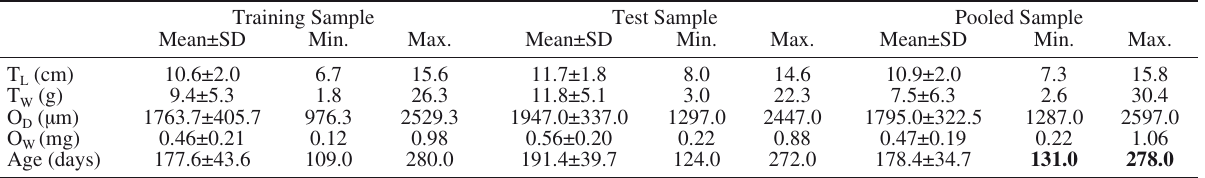
Table 2. – Summary statistics of sardine morphometric characteristics and age in the training sample, test sample and pooled sample. T fish length; T